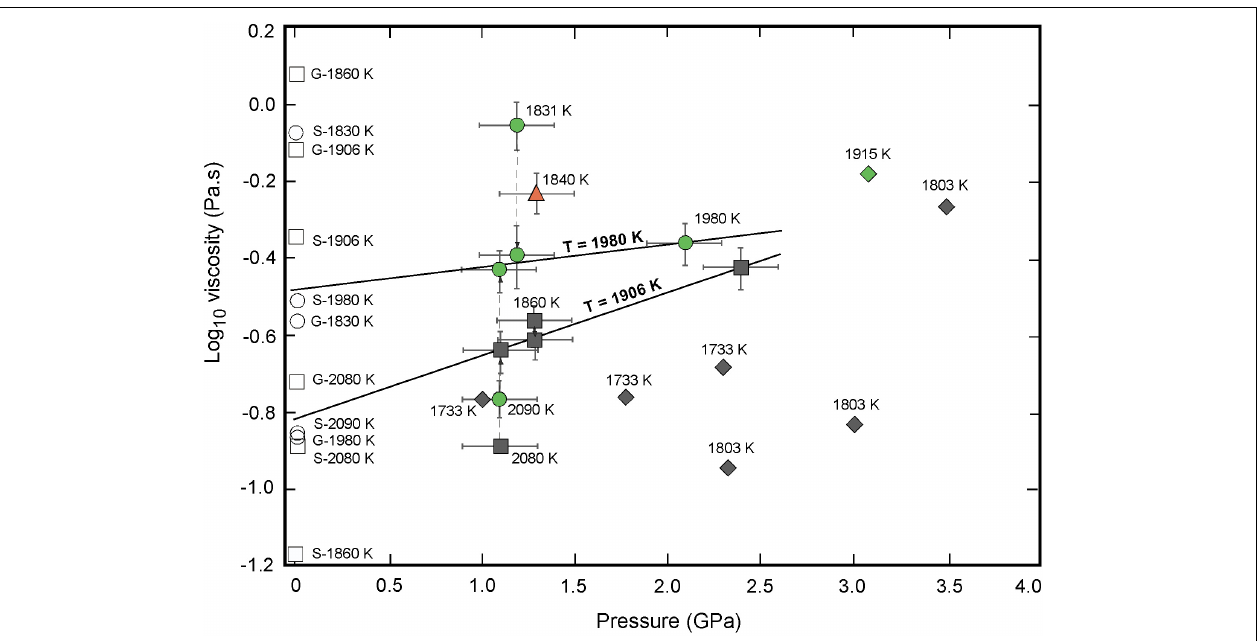
FIGURE 6 | Pressure dependence of viscosity for the green (circles) orange (triangles), and black (squares) lunar melts. The viscosities increase steadily between 1.1 and 2.4 GPa. The activation volume ( V ∗ ) of viscous flow for the green and black glasses were calculated along the 1980 and 1906 K isotherms, respectively, by fitting experimental data to Eq. 5. Literature data from Maeda et al. (2004; green diamond), Suzuki et al. (2009; black diamonds) are shown for comparison, as well as model predicted viscosity values at 1 atm and high-temperature by Giordano et al. (2008) and Sehlke and Whittington (2016) for the green (empty circles) and black (empty squares)